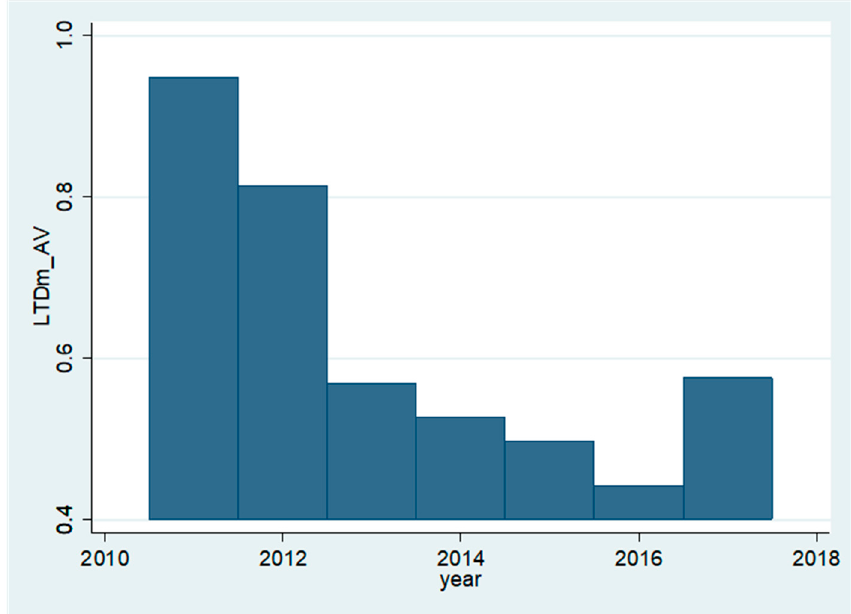
Figure A1. Average of loans-to-deposits maturity mismatch (LTD m ) of the EU banks. The LTD m remained stable from the second part of 2010 to 2012, decreased from 2013 to 2016 and increased from 2017. Source: Stata Statistical Software.